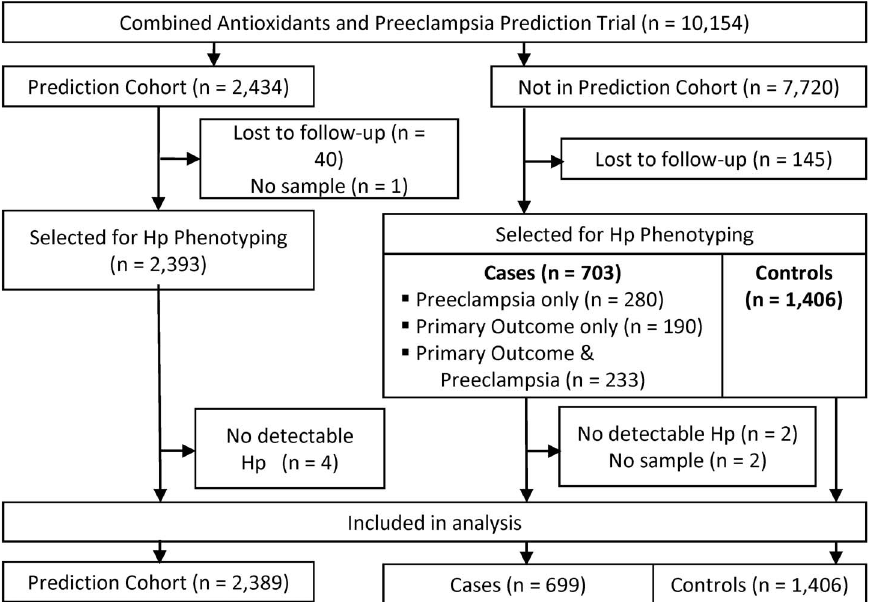
Figure 2. Study Flow Chart. Subjects lost to follow-up include 183 women who miscarried, one subject whose data were removed at the patient’s request, and one subject whose data were removed at the institutional review board’s